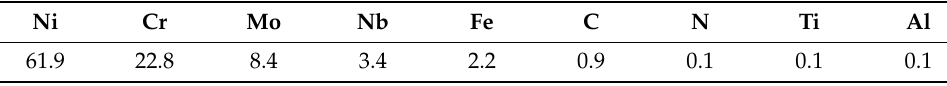
Table 1. Inconel 625 chemical composition (mass